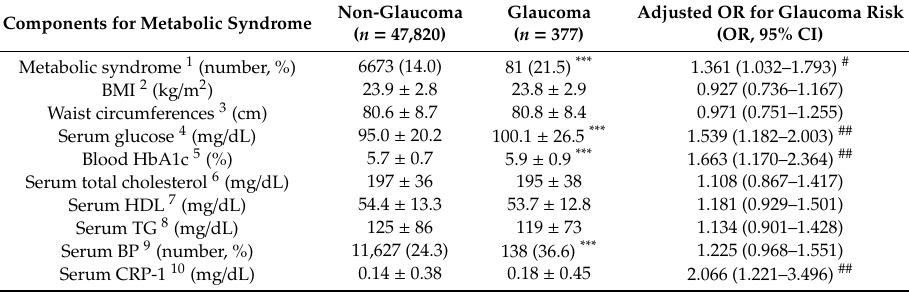
Table 2. The association of glaucoma risk and metabolic